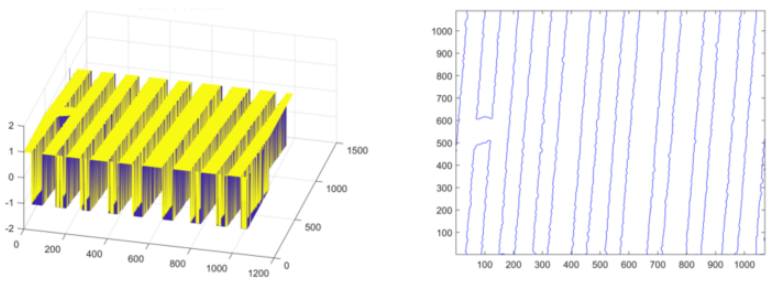
Figure 15. Evolution function and line extraction diagram after iteration.